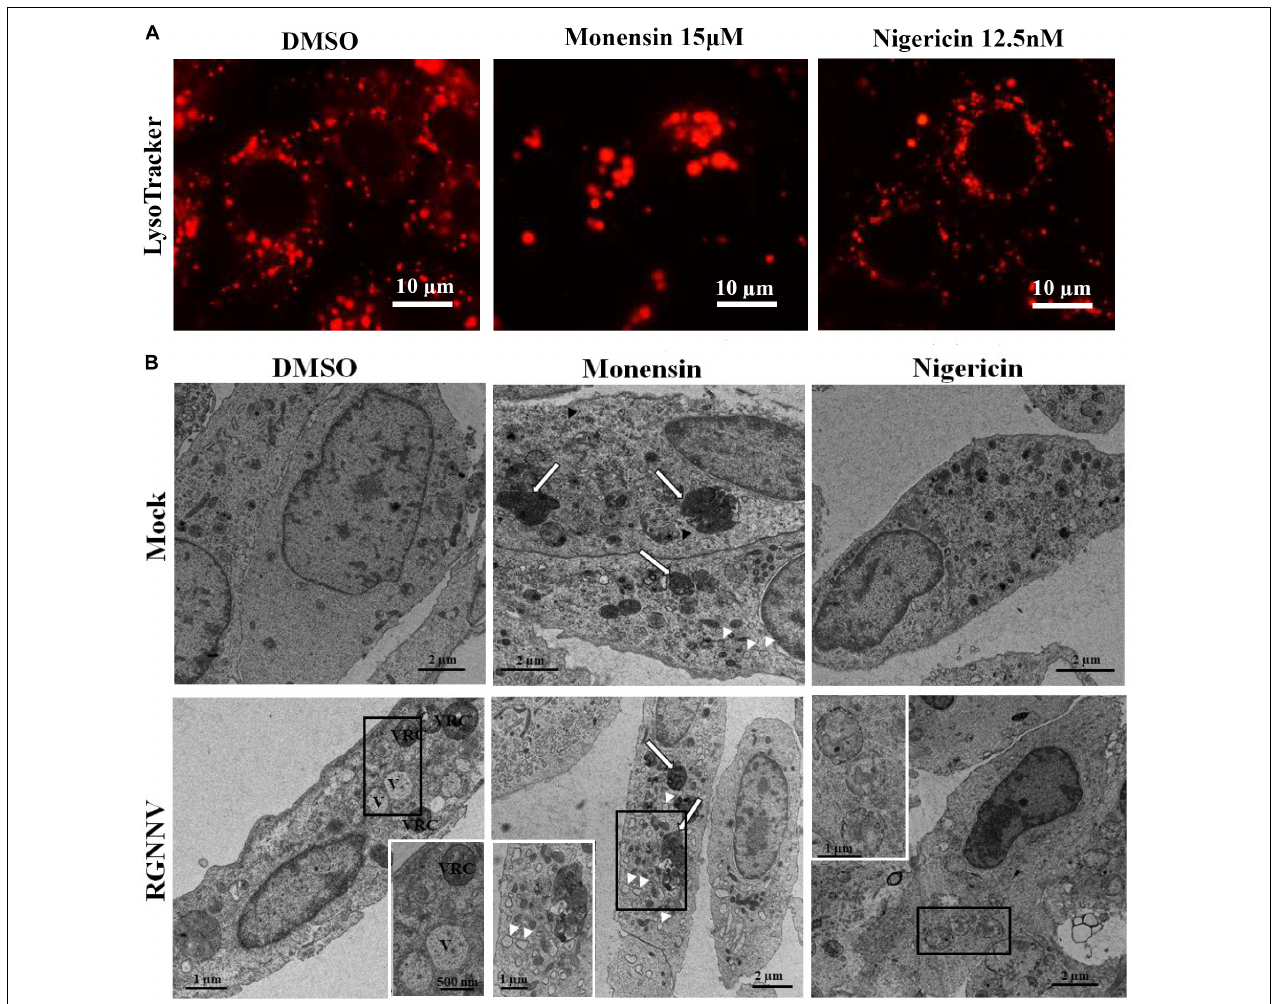
FIGURE 7 | The effect of nigericin and monensin on the lysosome structure during RGNNV infection. (A) The lysosome structure upon nigericin and monensin treatment using fluorescence microscopy. (B) The lysosome ultrastructure in RGNNV-infected cells under electron